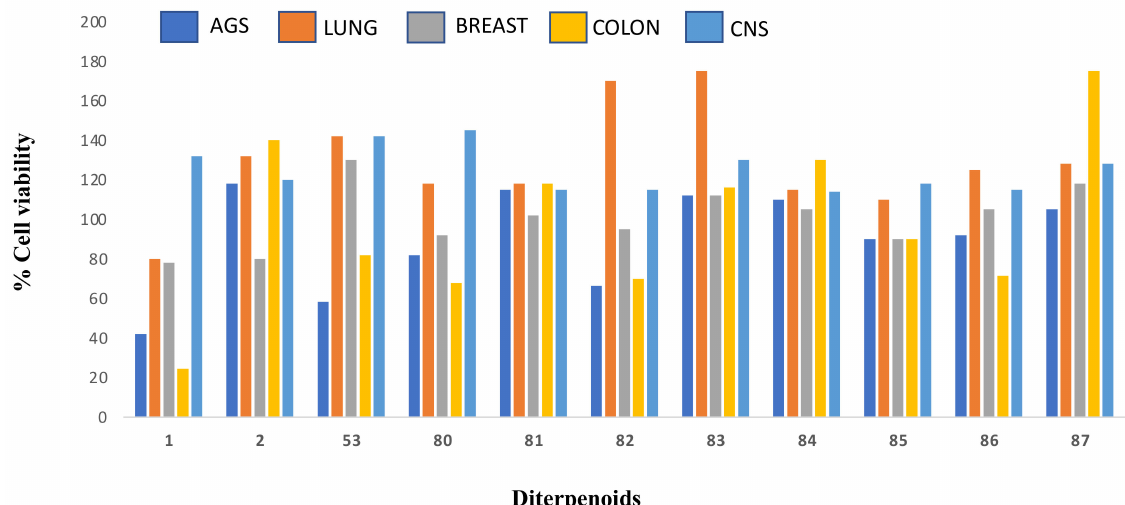
Figure 19. (+)-Stemodin ( 1 ) analogues cell viability against human gastric (AGS), NCI-H460 (lung), MCF-7 (breast), HCT-116 (colon) and SF-268 (central nervous system, CNS) cancer cell lines. Compounds were tested at 25 µ g/mL. Samples were prepared in DMSO (0.2%) supplemented with RPMI-1640 medium